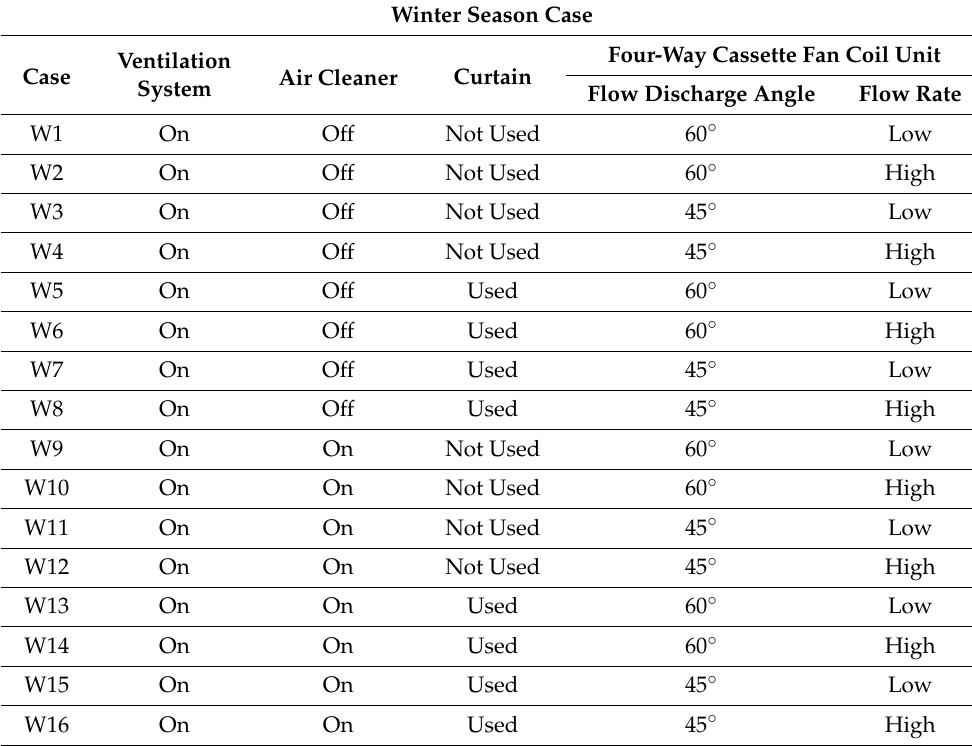
Table 2. Cases for heating mode of the four-way cassette fan coil unit in